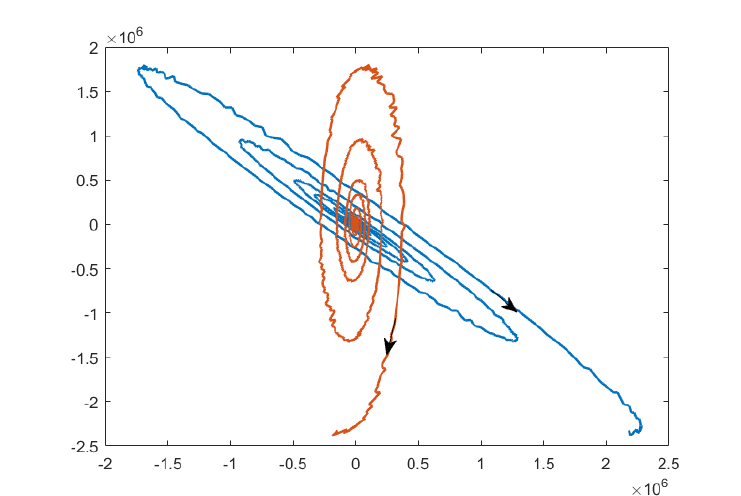
Figure 4. Phase plane of open-loop systems with initial conditions ( − 2, 2).